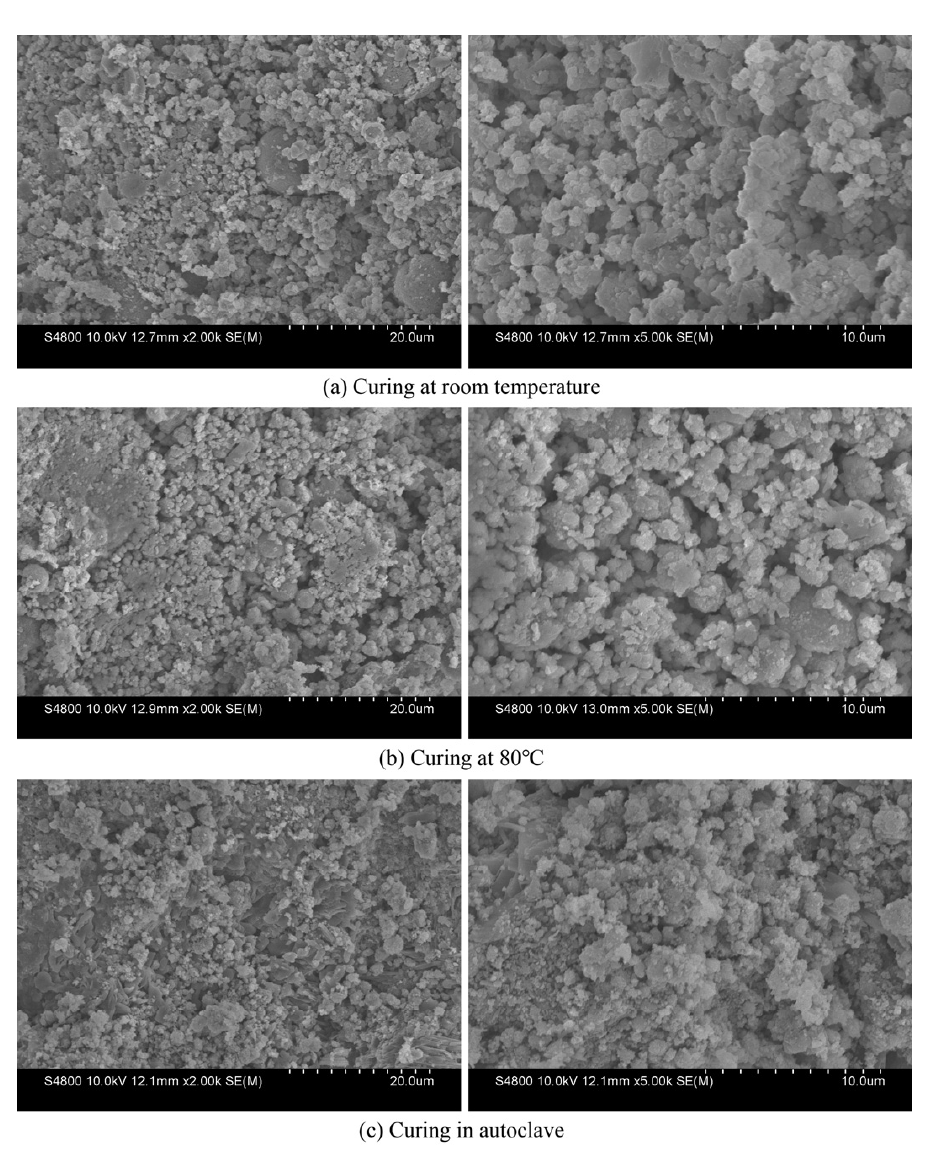
Figure 6. SEM photography of the RM-FA geopolymers with a 50% red mud content.